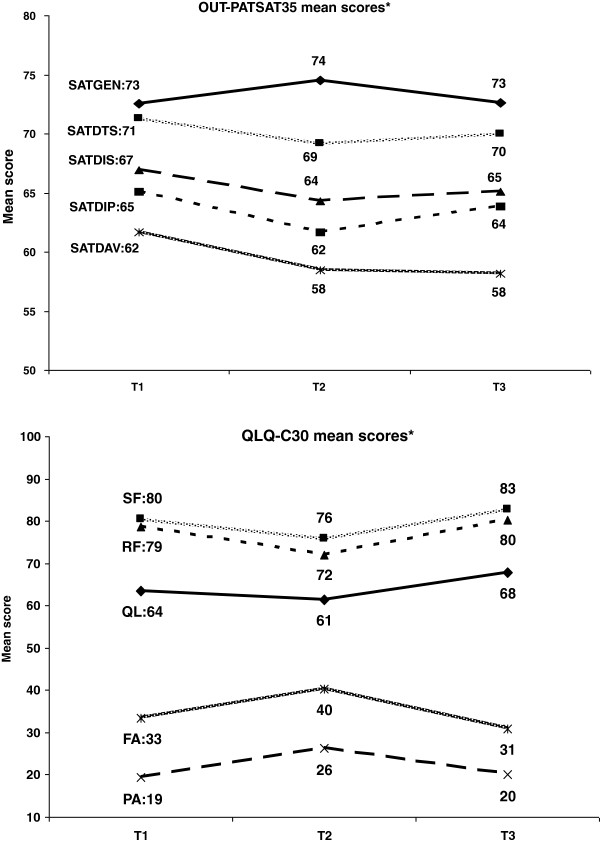
Longitudinal evolution of OUT-PATSAT35 and QLQC30 scores at the 3 assessment time points*. *Only the most representative dimensions are shown. Abbreviations: SATGEN = overall satisfaction, SATDTS doctor technical skills, SATDIS = doctor interpersonal skills, SATDIP = information provided by doctor, SATDAV = doctor availability, SF = social functioning, RF = role functioning, QL = global health, FA = fatigue, PA = pain. T1: start of treatment, T2 : end of treatment, T3 : three months after the end of treatment.